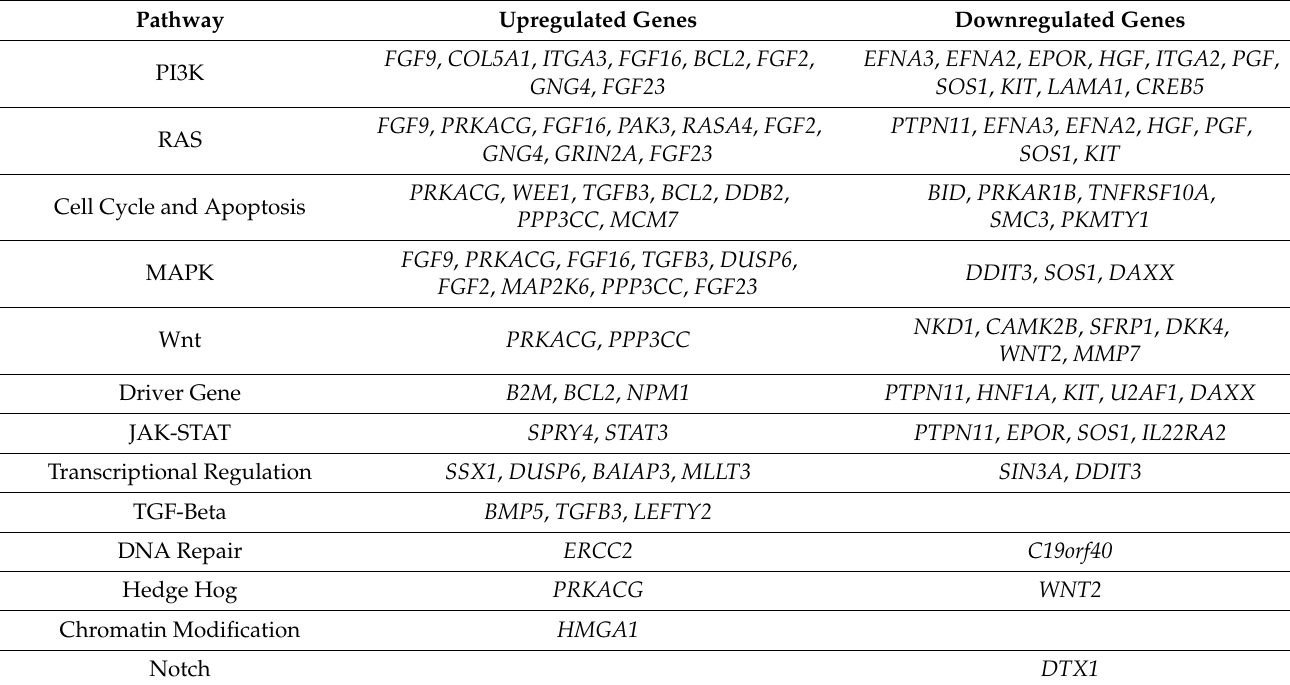
Table 4. Cancer pathways implicated in gene targets differentially expressed between non-tumor and tumor MF. Pathway